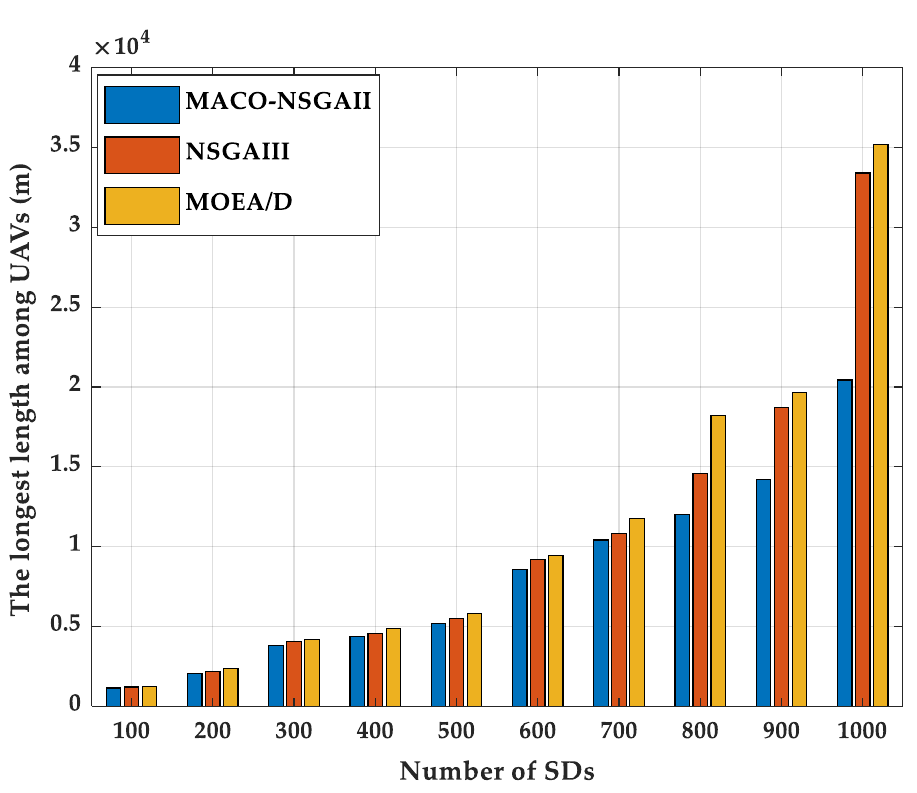
Figure 4. The longest trajectory of 6 UAVs with different algorithm.